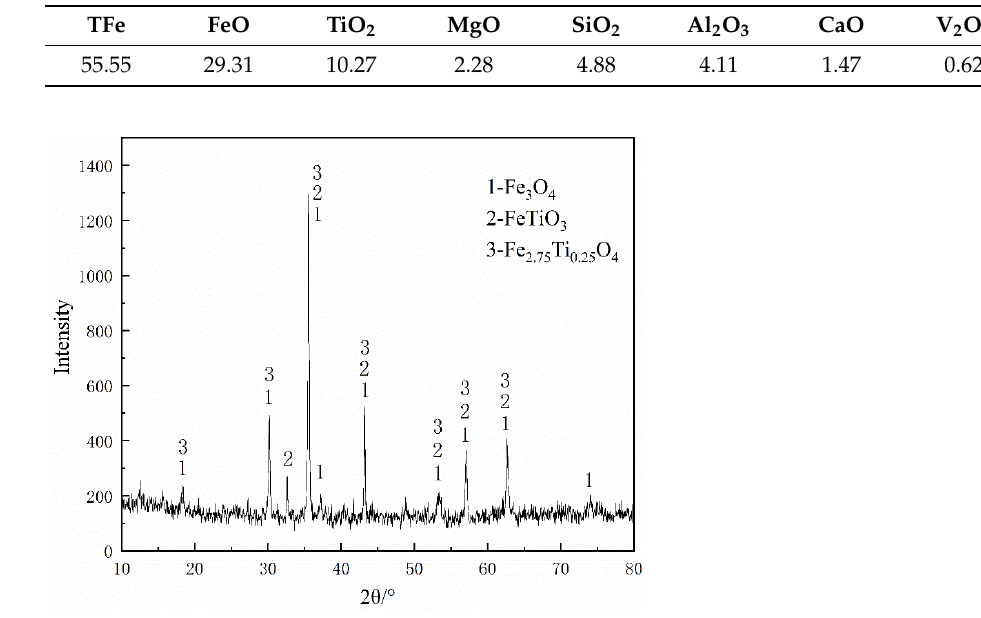
Figure 2. X-ray diffraction pattern of the VTM concentrate. Table 2. Proximate analysis and ash chemical composition of the coal (wt%). Proximate Analysis Ash Analysis